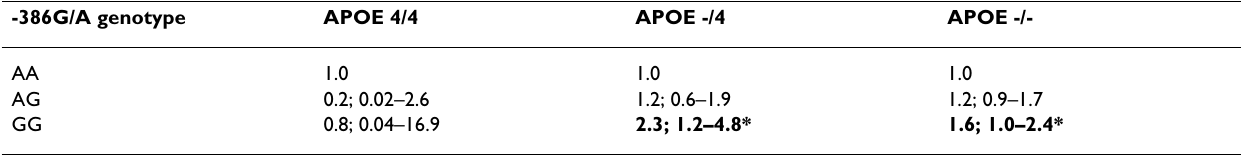
Table 5: Odds ratios for AD as a function of the -386G/A P3 promoter polymorphism stratified by the presence or absence of APOE ε 4 alleles -386G/A genotype